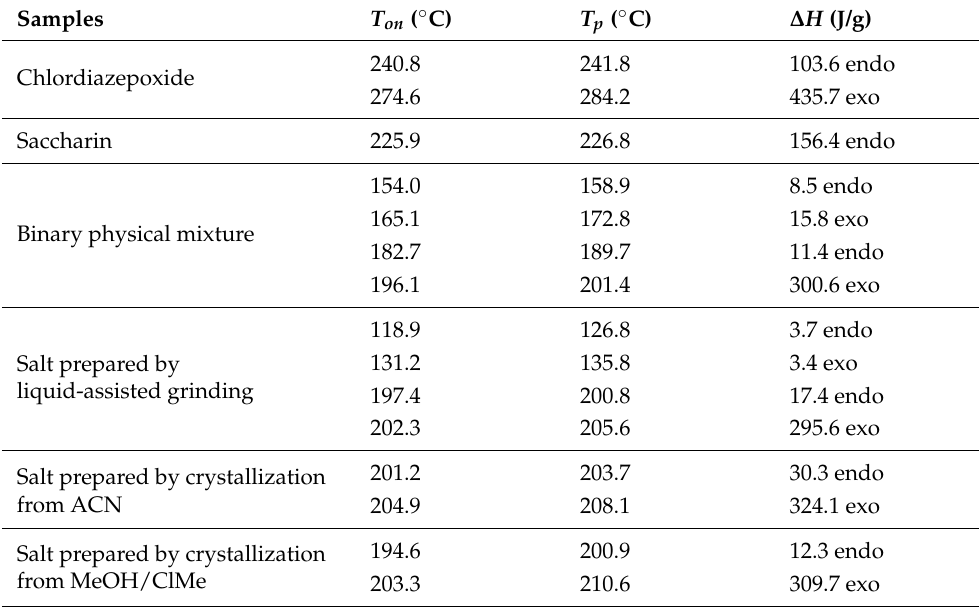
Figure 5. Images for saccharin salts of chlordiazepoxide prepared using the following methods: ( a ) liquid-assisted grinding, ( b ) crystallization from ACN, and ( c ) crystallization from MeOH/ClMe. Images were taken at 20 ◦ C. Table 5. Characteristic temperatures and heats of transitions acquired from the DSC peaks for chlordiazepoxide, saccharin, chlordiazepoxide mixture with saccharin, and saccharin salts of chlor- diazepoxide prepared by different methods. Measurements were taken at a heating rate of 10 ◦ C/min in